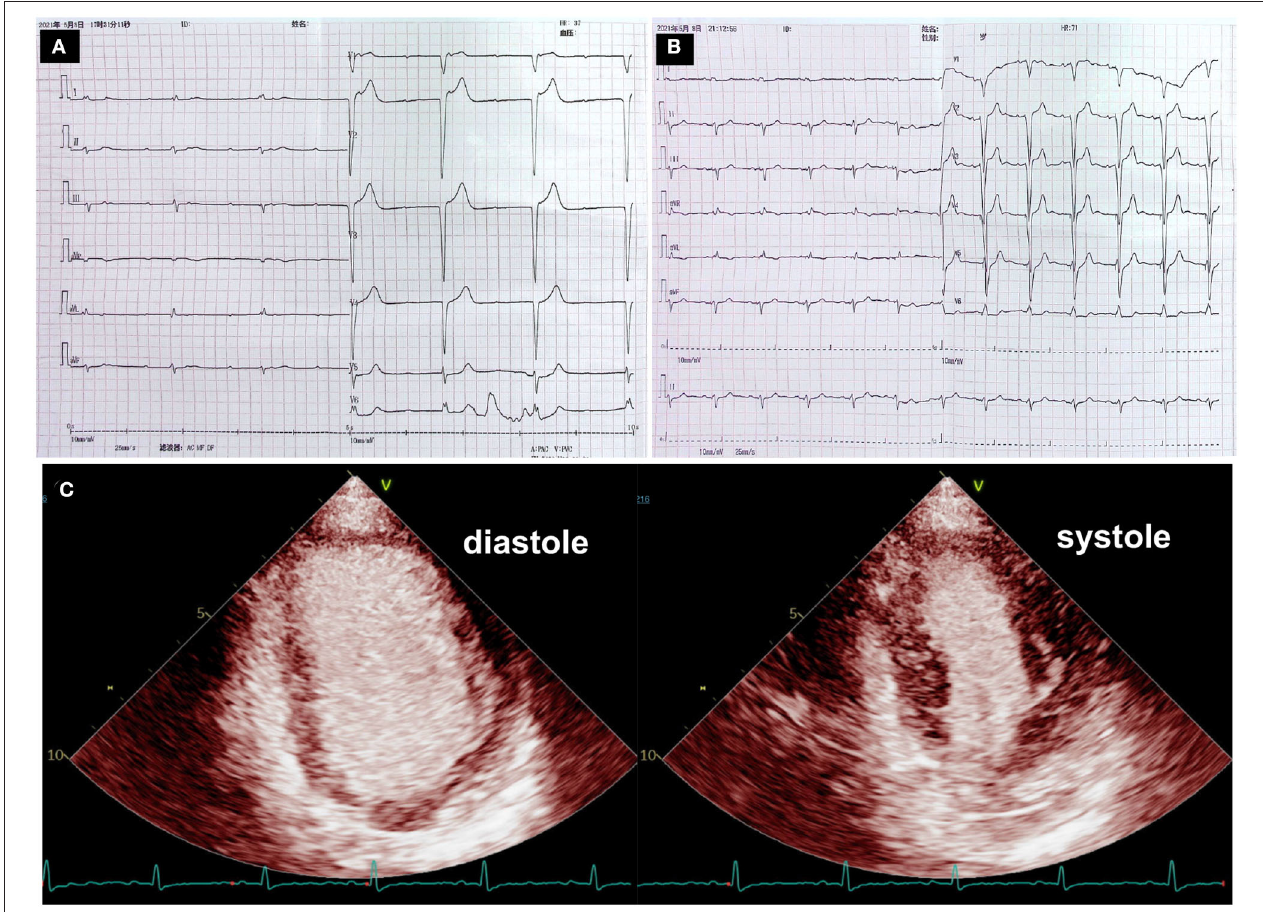
FIGURE 1 | Electrocardiogram and myocardial contrast echocardiography. (A) Electrocardiogram at the onset showed complete atrioventricular block with a ventricular escape at a rate of 37 beats per minute. (B) Echocardiogram after pacemaker implantation indicated a ventricular pacing rhythm with a wide QRS complex. (C) Myocardial contrast echocardiography examinations showed homogenous and equal enhancement intensity in the basal, middle and apical